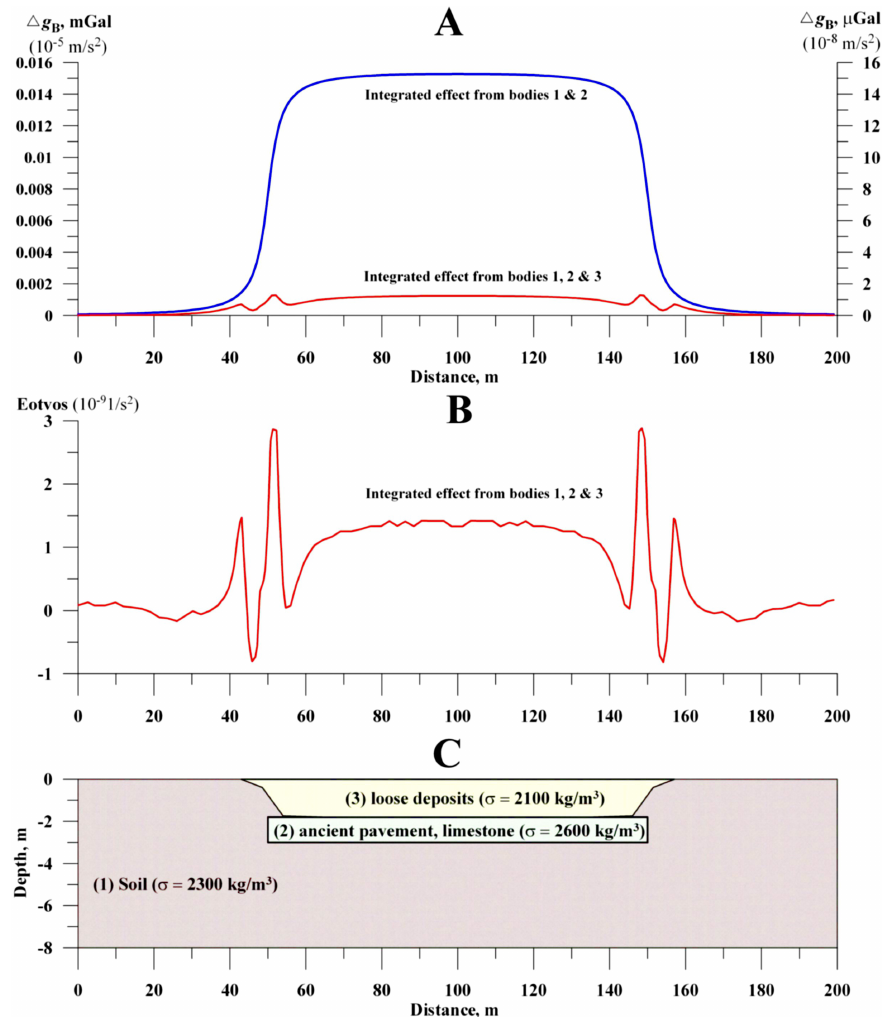
Fig. 15. Comparison of Bouguer gravity and vertical gradient anomalies for a model of buried pavement. ( A ) Bouguer gravity, ( B ) vertical gradient g z ( W zz ) computed for the base of 1.2m, ( C ) archaeological